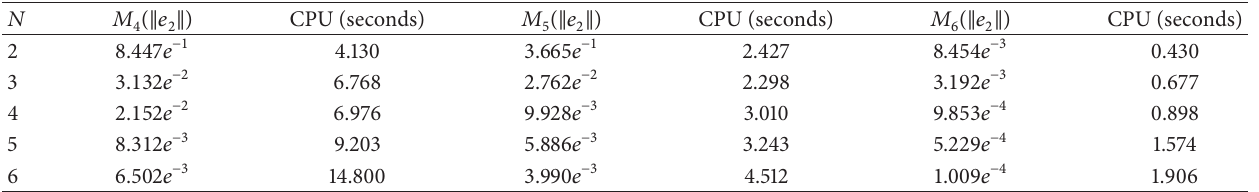
Table 3: Comparison of maximum absolute errors and CPU (seconds) for a Multigrid method with different schemes, for Example 3, ‖𝑒 2 ‖ , ℓ = 10 , and 𝑁 = 2, 3, 4, 5, 6 .